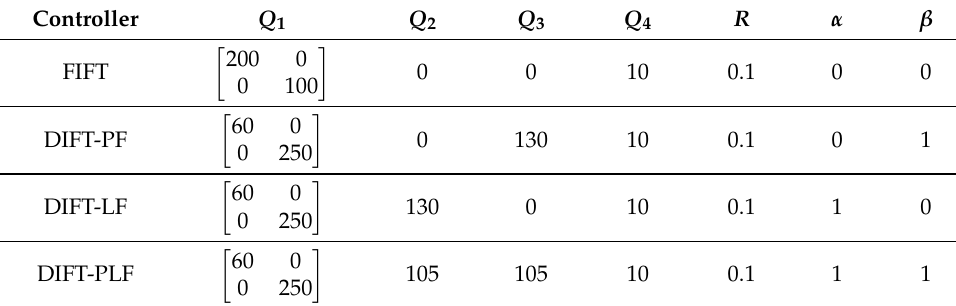
Figure 7. Co-simulation in Matlab/Simulink-TruckSim. Table 1. Control parameters in different